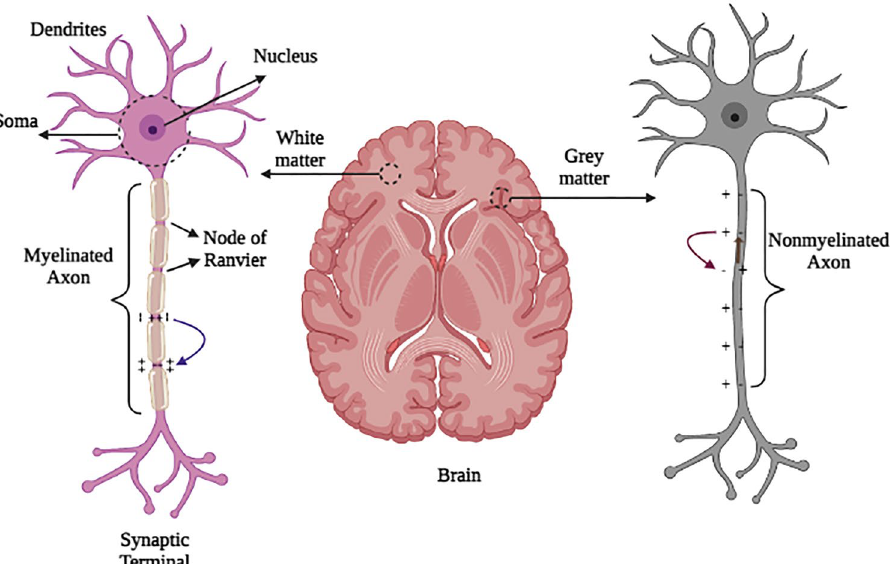
Figure 1. Schematic structure of two different neurons in the brain’s white matter and gray matter. Electrical variations that occur in stimulated ( a ) myelinated (salutatory conduction) and ( b ) nonmyelinated axons.